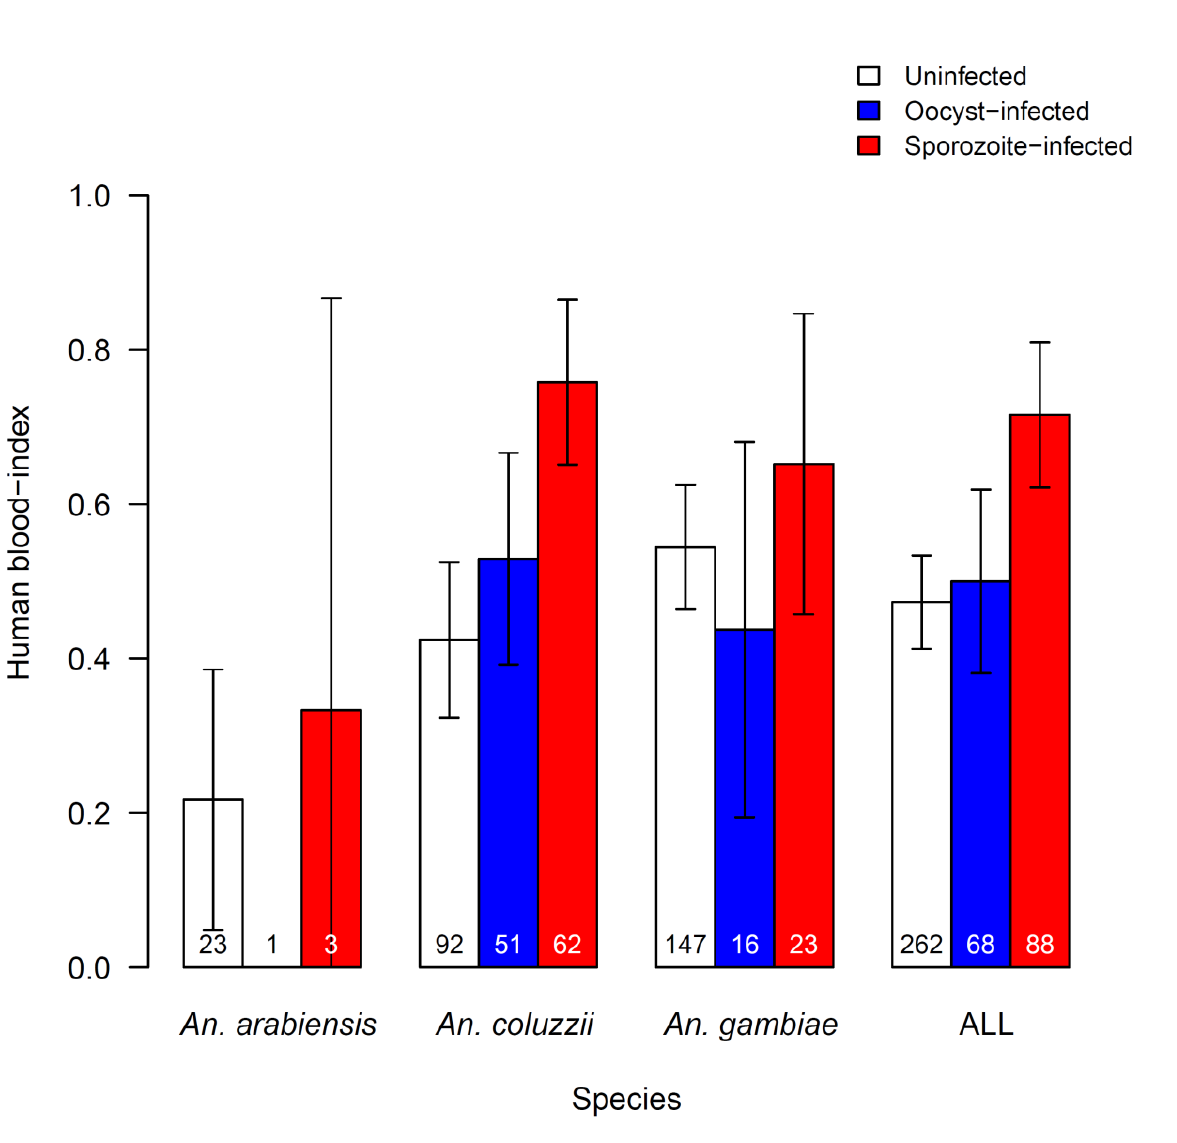
Figure 3. Effect of infection status and mosquito species on the human-blood index expressed as the proportion of females fed on humans or humans and animals out of the total of blood-fed females. Data show proportion ± 95% confidence intervals. Numbers in bars indicate the total numbers of mosquitoes. Finally, HBI was not significantly affected by parity, a proxy used to estimate mosquito age (nulliparous females: 49.53 ± 9%, parous females: 45.6 ± 7.5%; X 2 1 = 0.4, P =